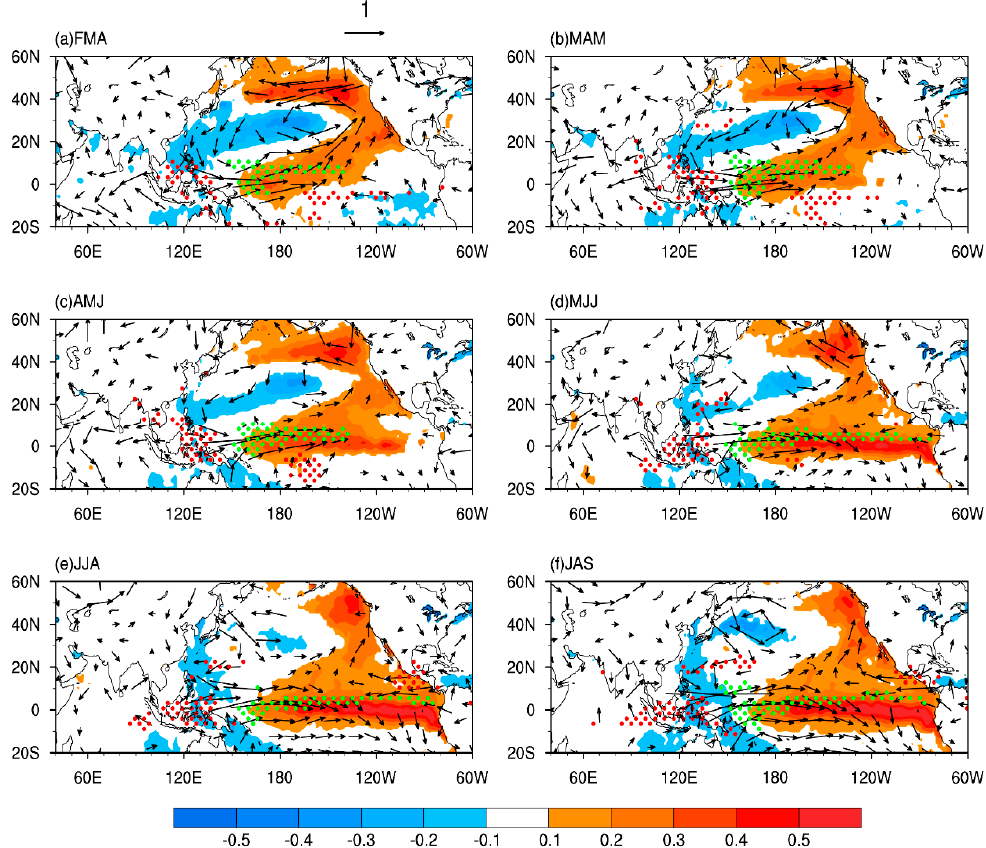
Figure 5. Regressions of the 3-month averaged SST (shading), wind vectors at 850 hPa (vector), and precipitation (stippled) anomalies onto the FMA VMI for FMA ( a ), MAM ( b ), AMJ ( c ), MJJ ( d ), JJA ( e ), and JAS ( f ). Positive (red) and negative (blue) SST anomalies, significant at the 90% confidence level, are shaded. Positive (green) and negative (red) precipitation anomalies significant at the 80% confidence level are stippled. Only 850 hPa wind vectors significant at the 90% confidence level are shown.